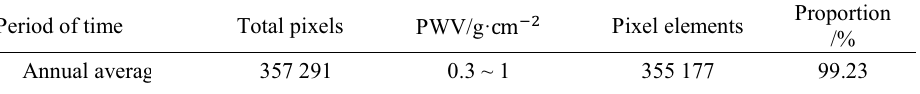
Table 2. Main water vapor distribution and area ratio in each period from 2016 to 2019 Period of